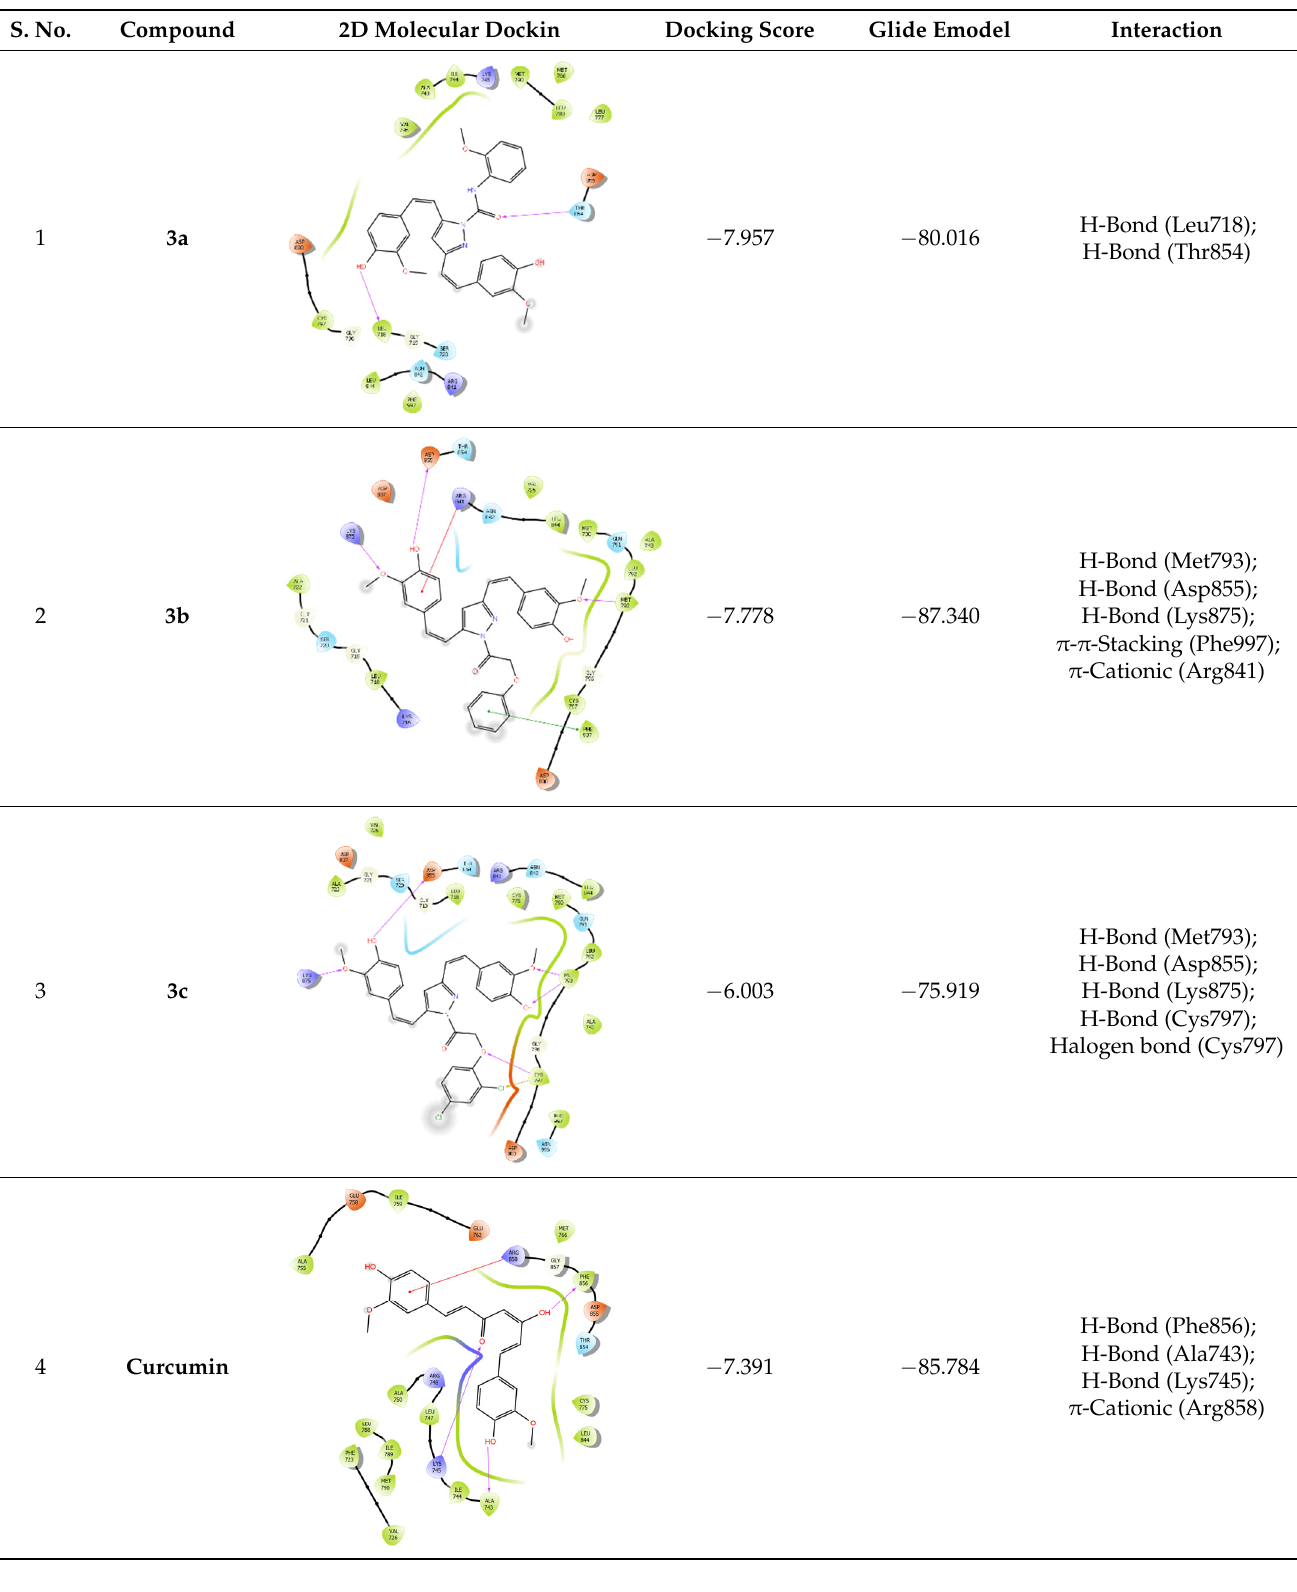
Table 4. The molecular docking results of curcumin analogues against EGFR.